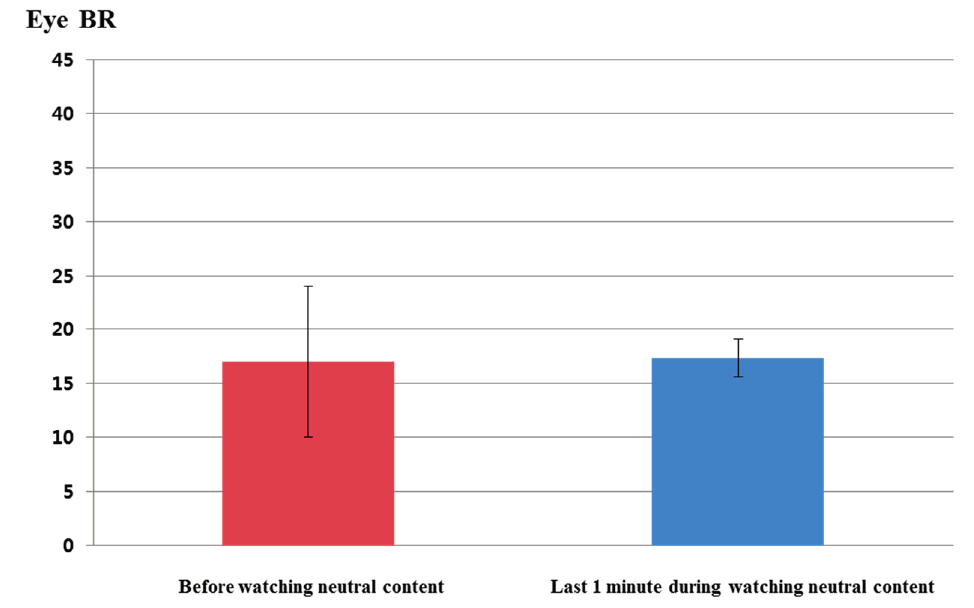
Figure 19. Comparisons of eye blinking rate before and in the last 1 min of watching the video clip of emotionally-neutral content to the subjects (BR is blinking